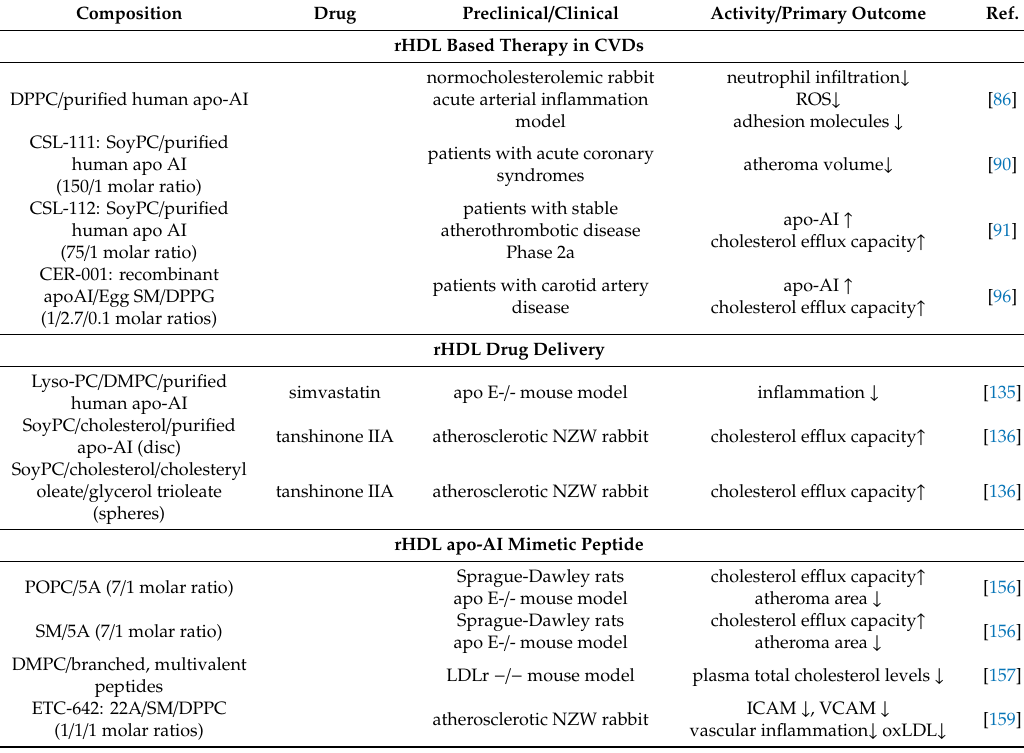
Table 1. Representative examples of various rHDL nanoparticles designed for the therapy of